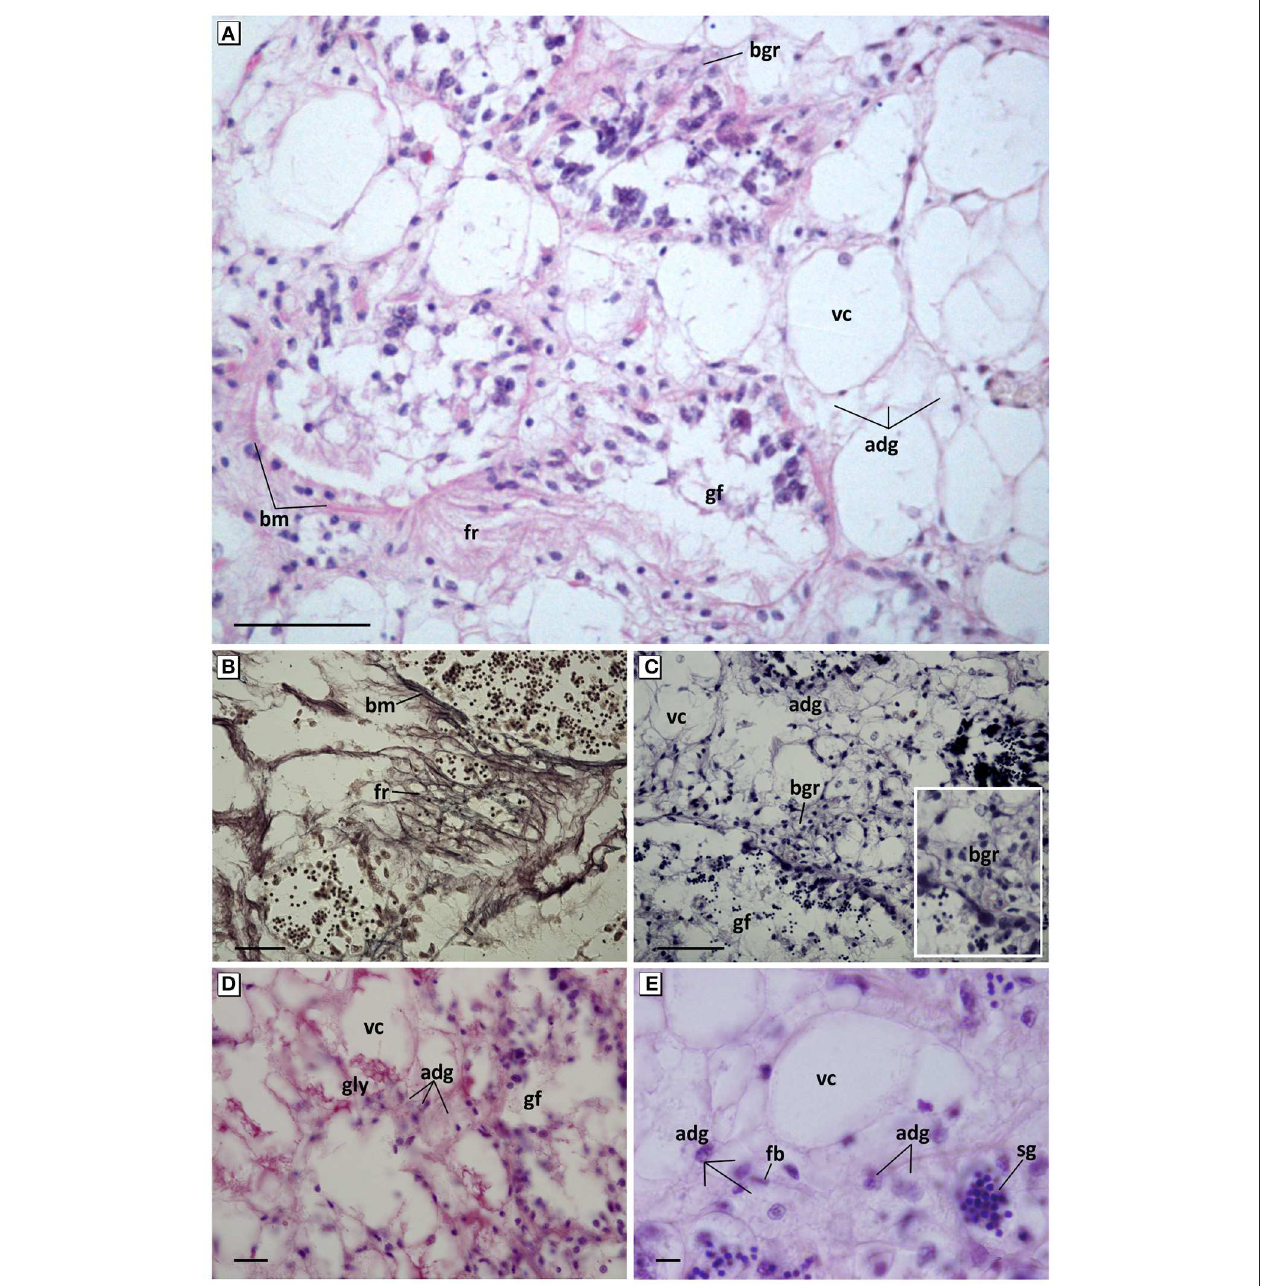
FIGURE 4 | Pathological features of connective tissue cells. (A) Overview of hyperplasia, fibrotic reaction of connective tissue, and basophilic granulocytes. Haematoxylin and eosin stain. (B) Detail of reticulin fibers and the thickening and break of the basement membrane of the gonadal follicles. Gomori methenamine-silver nitrate stain. (C) Hypertrophy and hyperplasia of VC and ADG cells; appearance of cluster of basophilic granulocytes around the gonadal follicles. Aniline blue stain. (D) Decrease of accumulated glycogen in VC cells and increase of small granules in ADG cells. PAS stain. (E) Foamy aspect with refringent microvesicles and loss